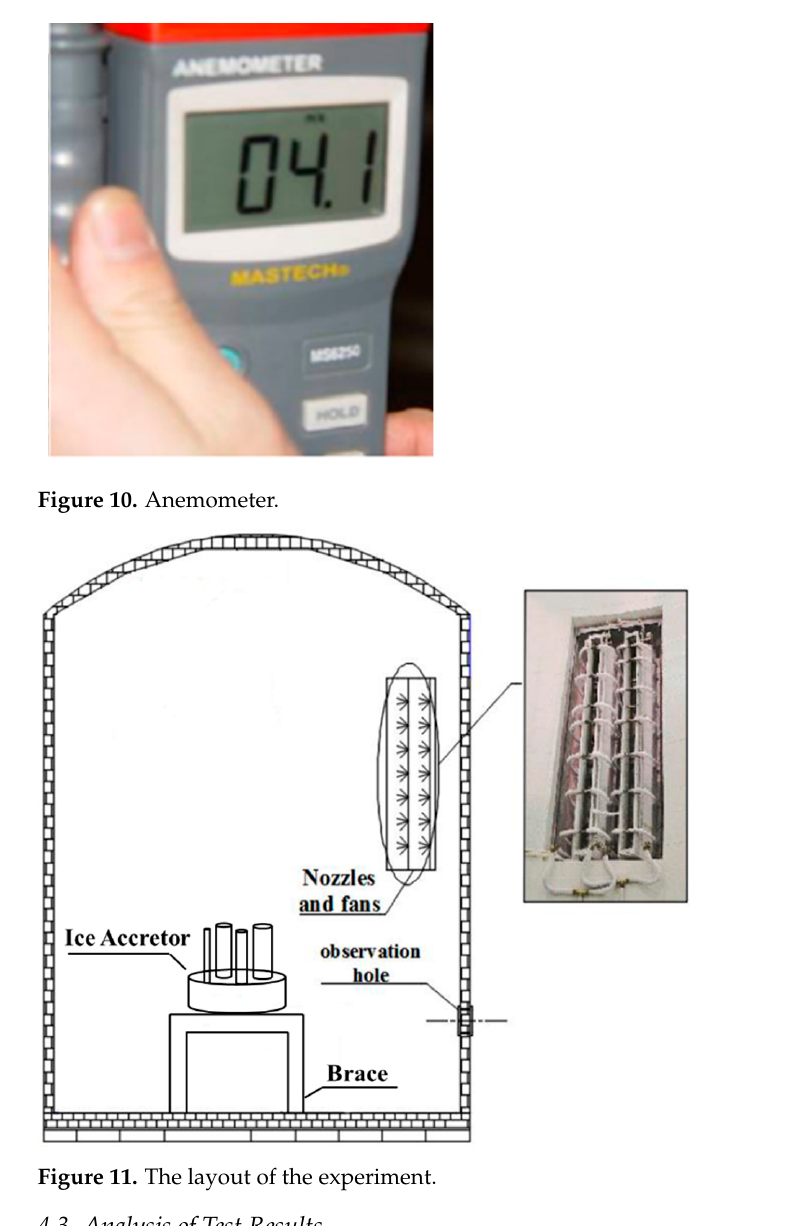
Figure 9. Temperature and humidity sensor.